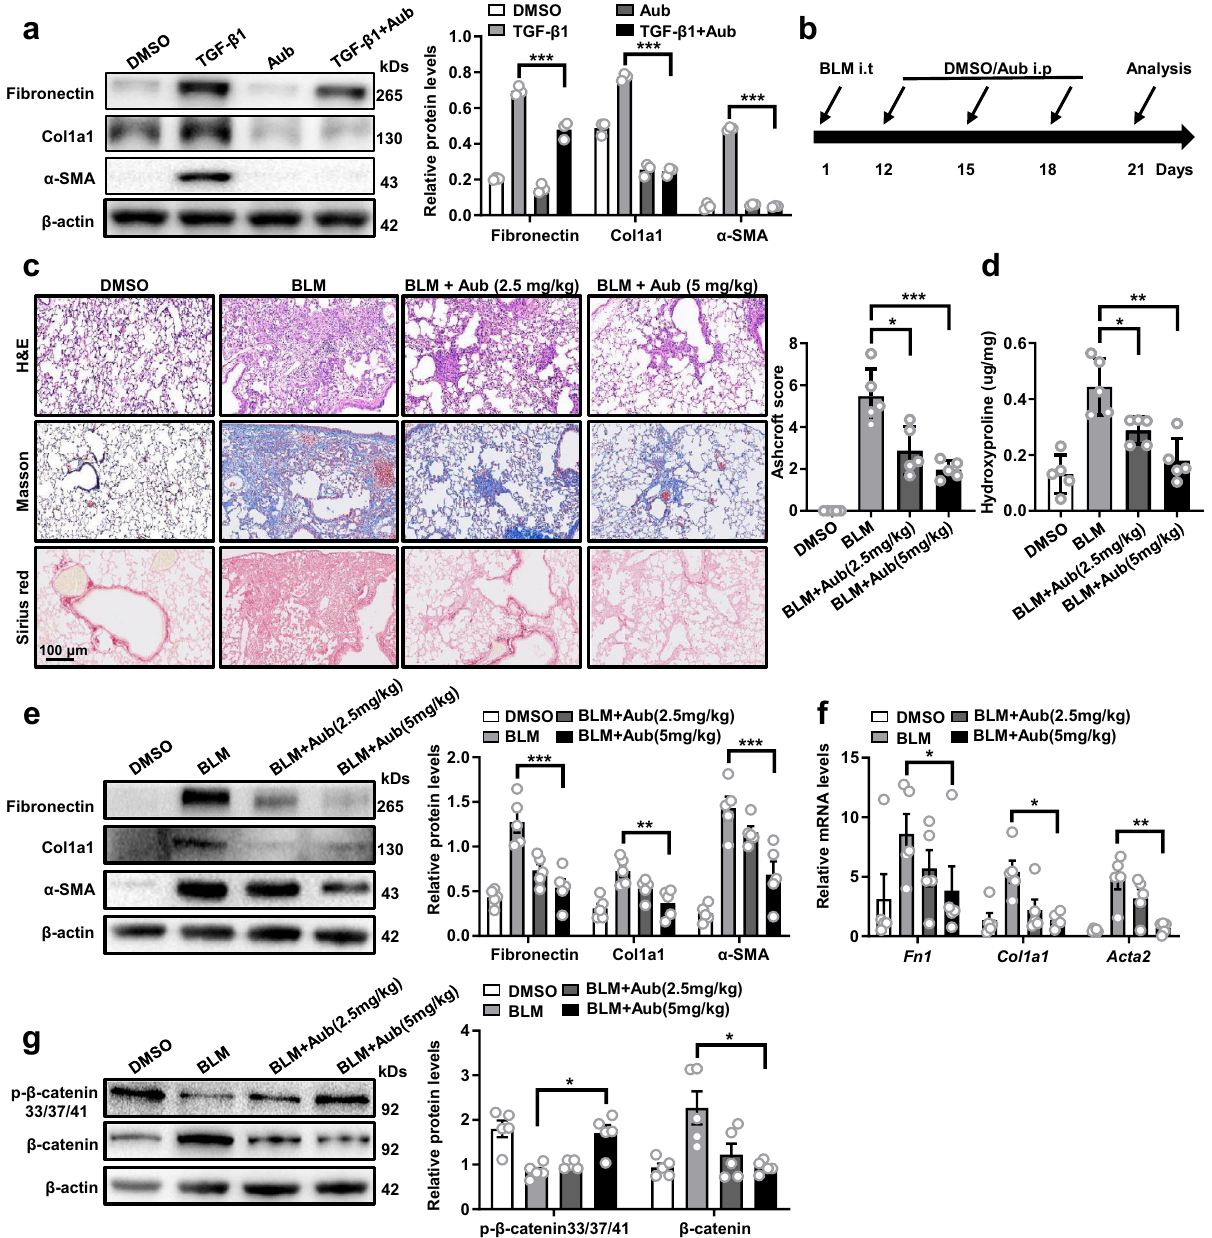
Fig. 8 Treatment with AubipyOMe (Aub) reversed the established pulmonary fi brosis. a Western blot analysis of Fibronectin ( p < 0.0001), Col1a1 ( p < 0.0001) and α -SMA ( p < 0.0001) in AubipyOMe treated PMLFs after TGF- β 1 stimulation, Dimethyl Sulfoxide (DMSO) treated as control group. b Schematic diagram for BLM-induced model of pulmonary fi brosis and the AubipyOMe-delivery method (i.t: Intratracheal instillation, i.p: intraperitonea). c Histological analysis of the severity of lung fi brosis in mice after BLM induction. Left panel: representative images for H&E (top), Masson staining (middle) and Sirius red (bottom). Right panel: A bar graph showed the quantitative mean score of the severity of fi brosis. Images were captured at ×200 magni fi cation. (BLM versus BLM with 2.5 mg/kg AubipyOMe: p = 0.0110, BLM versus BLM with 5.0 mg/kg AubipyOMe: p = 0.0005) d Quanti fi cation of hydroxyproline contents. (BLM versus BLM with 2.5 mg/kg AubipyOMe: p = 0.0147, BLM versus BLM with 5.0 mg/kg AubipyOMe: p = 0.0018) e-f Western blot ( e ) and RT-PCR ( f ) analysis of Fibronectin ( e : p < 0.0001, f : p = 0.0146), Col1a1 ( e : p = 0.0066, f : p = 0.0101), and α -SMA ( e : p < 0.0001, f : p = 0.0083) expression. g W e stern blot analysis of the levels of β -catenin ( p = 0.02241) and p- β -catenin (S33, S37 and T41, p = 0.0213). Each bar represents the mean ± SEM of 5 mice analyzed. Two-sided Student ’ s t test ( a – g ) and two-sided unpaired Student ’ s t -test wi t h Welch ’ s correction ( f , g ) were applied. * p < 0.05; ** p < 0.01; *** p < 0.001. Source data are provided as a Source Data fi